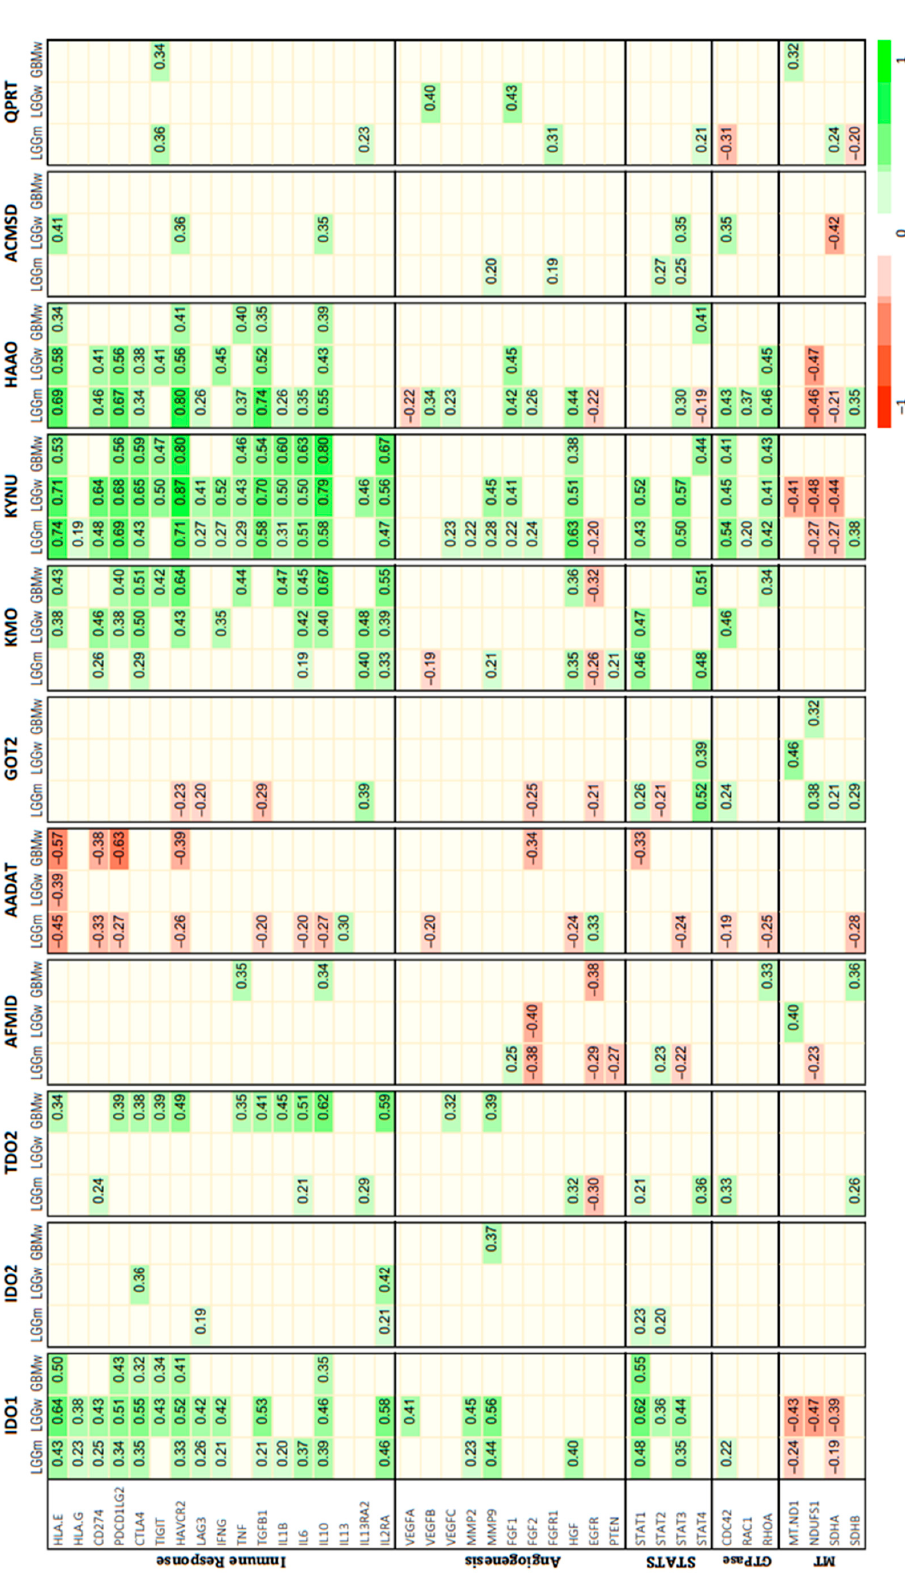
Figure 2. Heat map of Spearman’s correlations between the kynurenine pathway expression and diverse glioma hallmarks. Only the significant correlations when considering the Holm adjustment for multiple tests in each group of samples are presented.